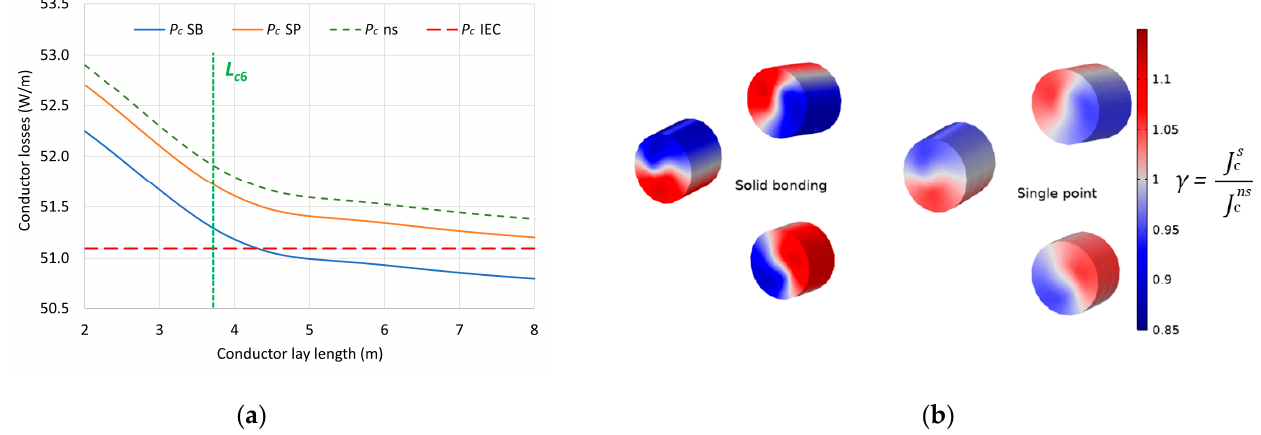
Figure 10. ( a ) Evolution of the conductor losses as a function of the lay length for SP, SB and with no sheaths, and ( b ) variations in the conductor current density distribution due to the presence of the sheaths in Cable 6 (unarmored, phase current 1100 A).